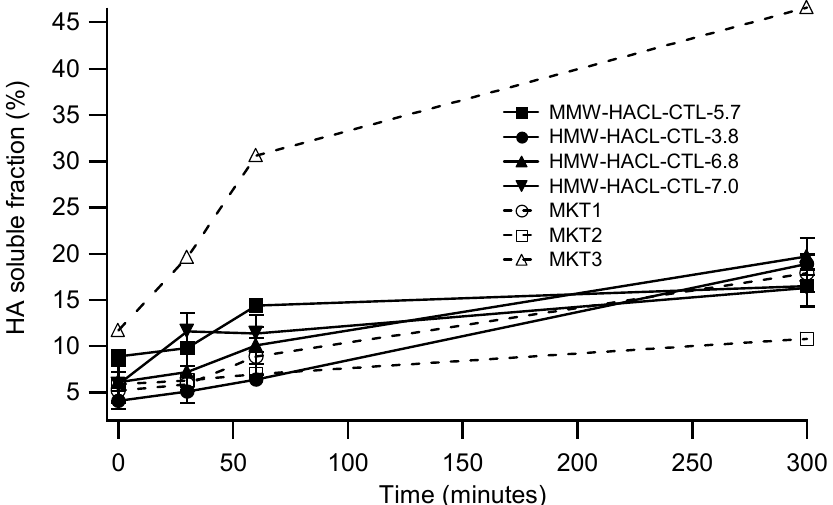
Figure 1. Hyaluronic acid (HA) soluble fraction after incubation with Bovine Testicular Hyaluronidase (BTH) 5 U/mL at 37 °C at different times (0, 30, 60 and 300 min). MKTx samples are commercial products analyzed for comparison. For clarity and to aid comparison, error bars are shown only for some of the samples. Lines are included only to guide the eyes.